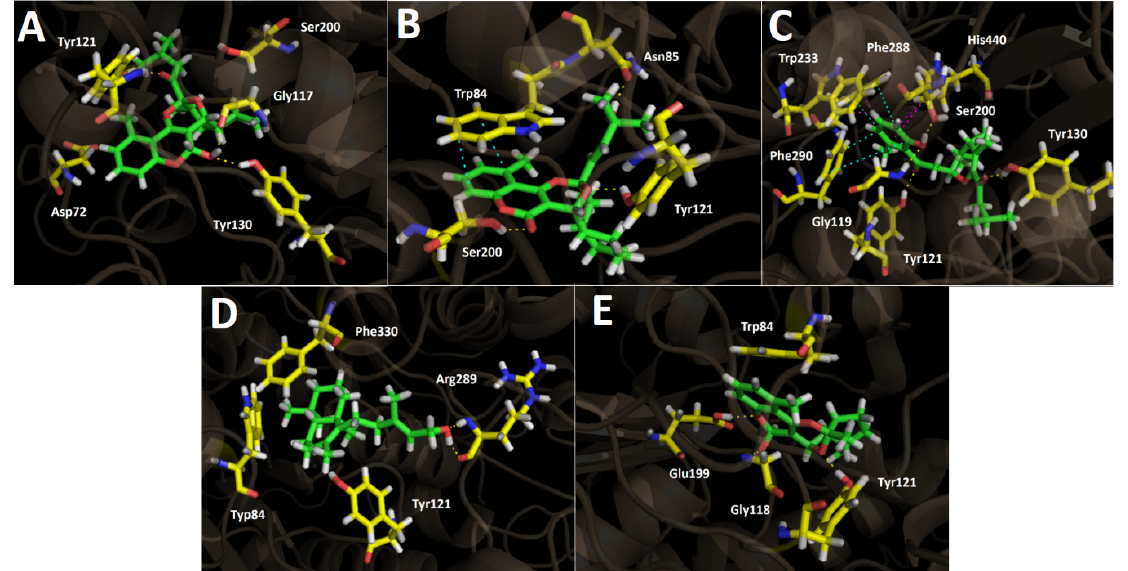
Figure 6. Predicted binding mode and predicted intermolecular interactions of selected major metabolites from the Gypothamnium pinifolium n -hexane and ethyl acetate extracts and the residues of Torpedo Californica acetylcholinesterase ( Tc AChE) catalytic site. Yellow dotted lines indicate hydrogen bond interactions, cyan dotted lines represent π - π interactions, and magenta dotted lines represent T-shaped interactions. ( A ) Cyclolycoserone in the catalytic site; ( B ) 8- epi -gypothaminol in the catalytic site; ( C ) 2- nor -1,2-secolycoserone in the catalytic site; ( D ) Ent -labda-8,13- E -diene-15-ol in the catalytic site; ( E ) 6 ‐ hydroxyaphyllodenticulide in the catalytic site.